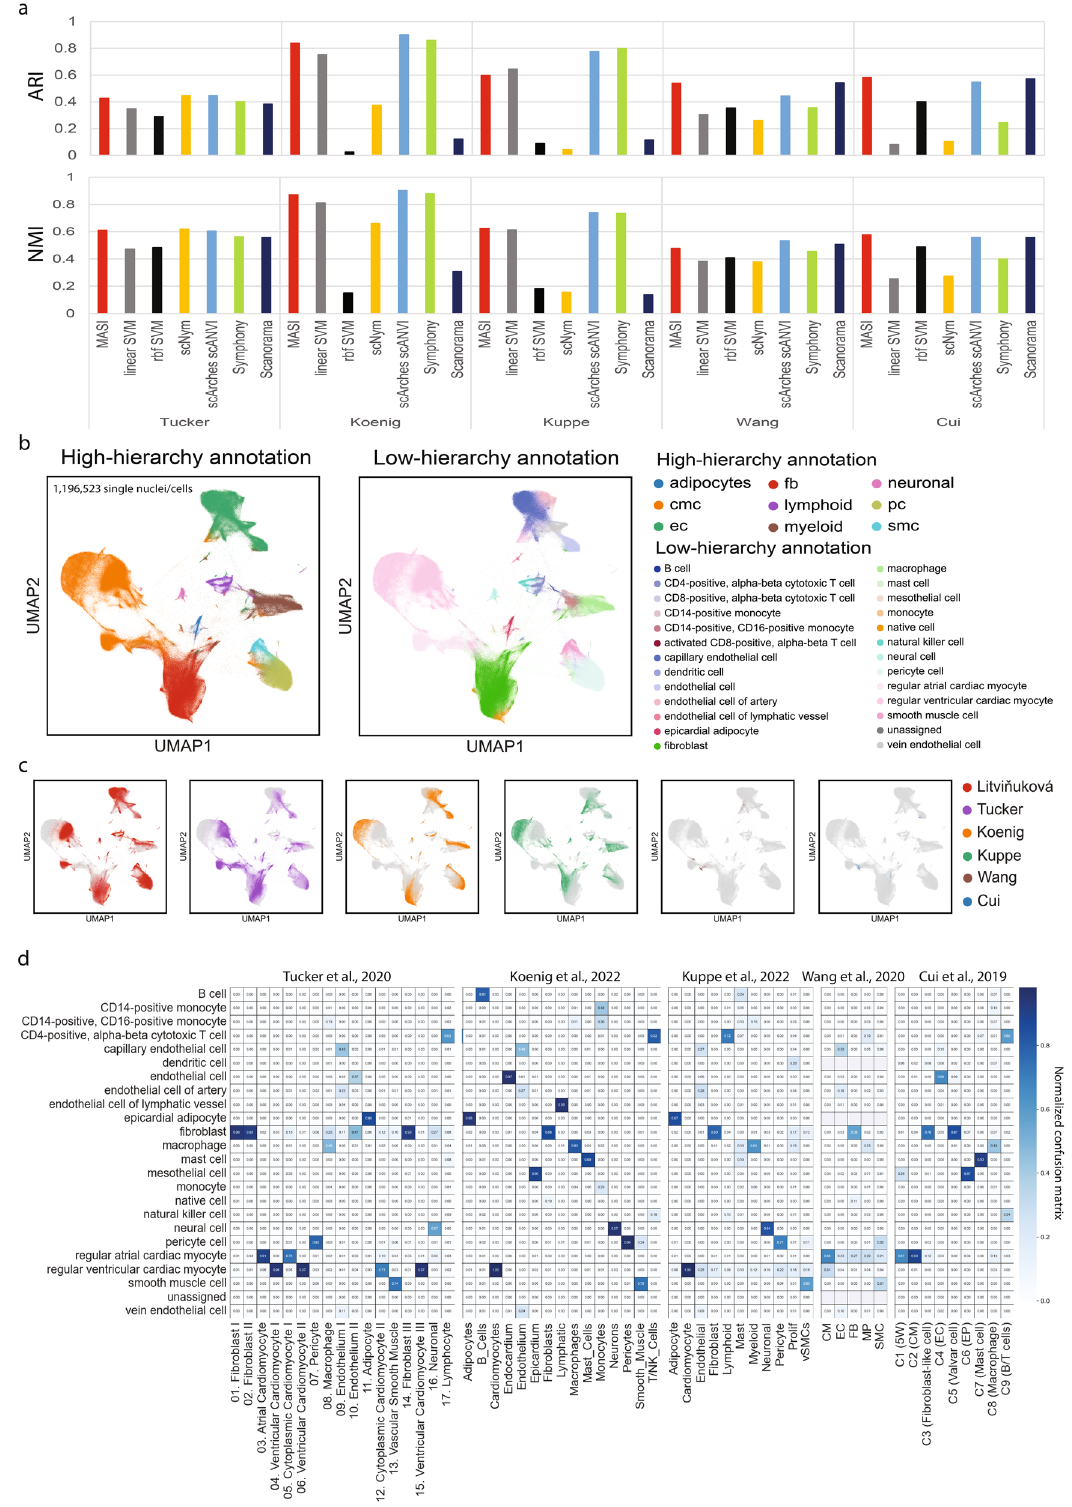
Fig. 6 Transferring human heart atlas for integration of single-cell human heart across research groups. a Comparison of label transferring for MASI, supervised, and semi-supervised methods. ARI and NMI are calculated by comparing method-reported annotation with author-reported annotation in a study-wise manner. b Visualization of the integrative annotation by MASI. Cells are colored according to MASI-reported cell-type annotation at both high and low hierarchy levels. c Visualization of integration by MASI. Cells are colored according to the study id. d confusion matrix of MASI-reported annotation against author-reported annotation. Confusion matrix is normalized to have column sum as 1. Row names use the naming style of human heart atlas, and column names remain the original naming styles of Tucker et al. 13 , Koenig et al. 66 , Kuppe et al. 67 , Wang et al. 69 , and Cui et al. 68 data.